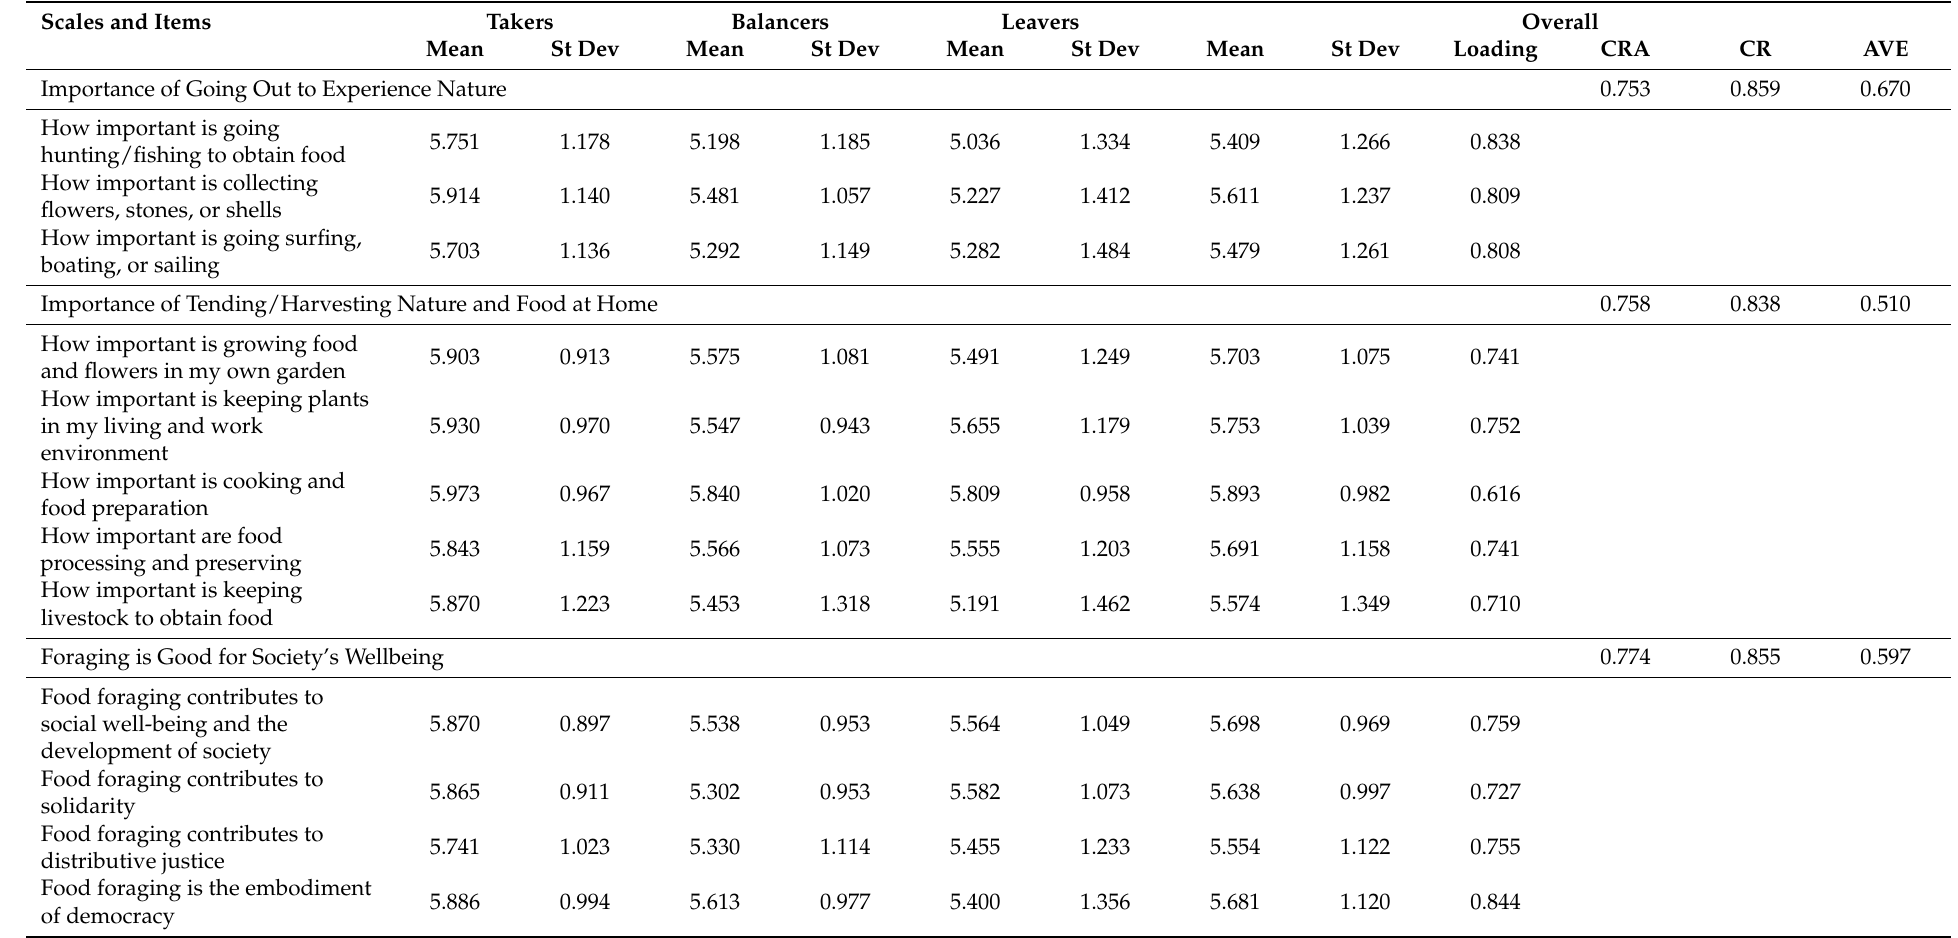
Table 2. Scale Loadings, Reliabilities, and Convergent Validity for Multi-Item